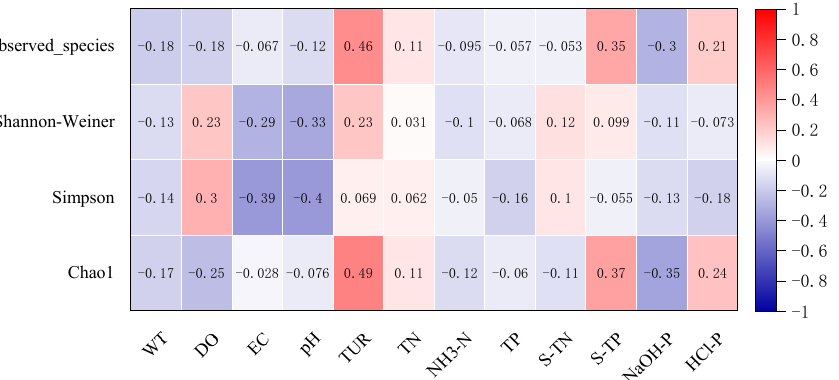
Figure 4. Correlation coefficients among environmental variables and microbial community Figure 4. diversity indices.